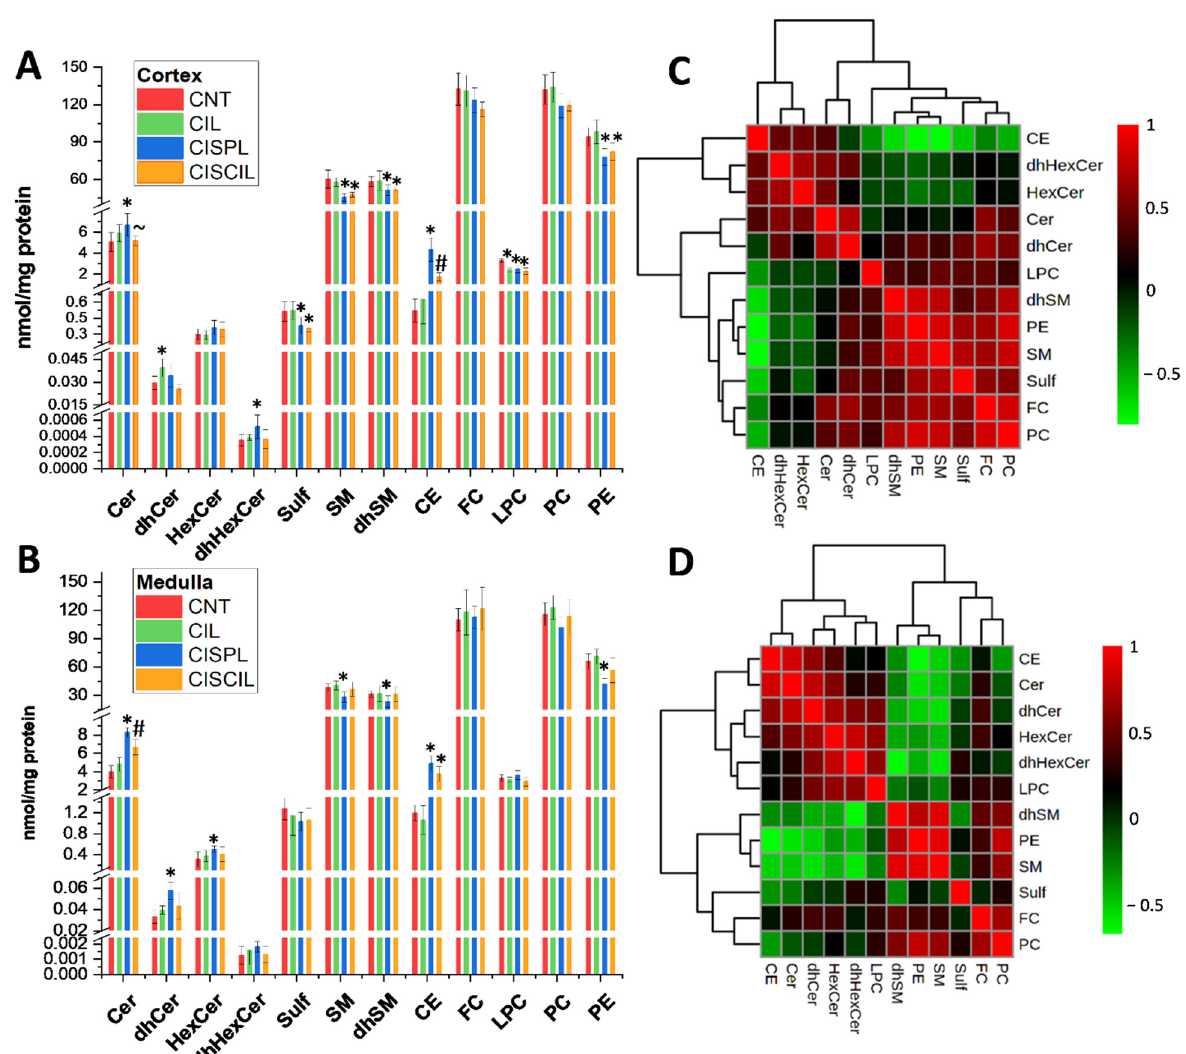
Figure 2. Global effect of cisplatin and cilastatin on renal lipids. Total levels of lipid classes for control (CNT), cilastatin (CIL), cisplatin (CISPL), and cisplatin + cilastatin (CISCIL) groups are presented in the renal ( A ) cortex and ( B ) medulla. Correlation heatmaps are displayed for lipid classes in the ( C ) cortex and ( D ) medulla. * p < 0.05 vs. CNT. ~ p < 0.05 vs. CISPL # p < 0.05 vs. CNT and CISPL. False discovery rate (FDR) < 0.1 was used. Data are presented as the mean ± sd; n = 6 animals per group.